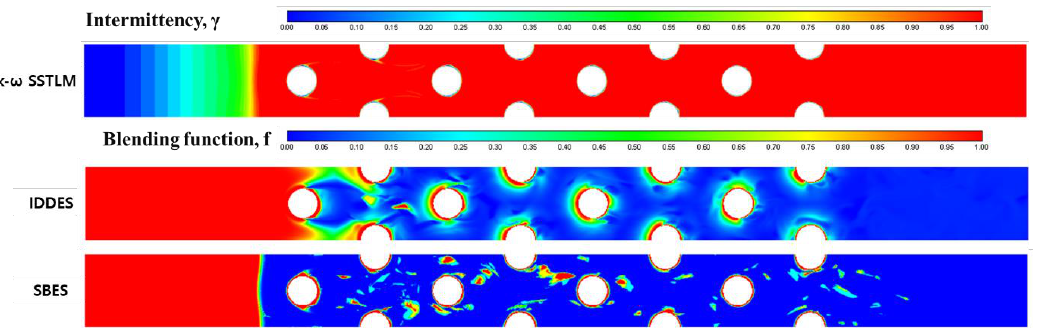
Figure 13. Intermittency and blending function distributions on the xz-plane at the mid-line of the y-axis.